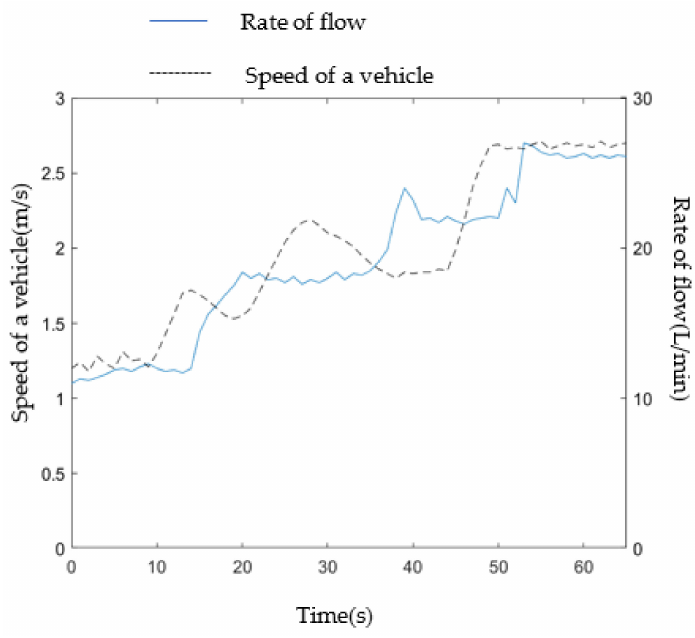
Figure 19. Test results of liquid manure flow by BPNN–PID control.